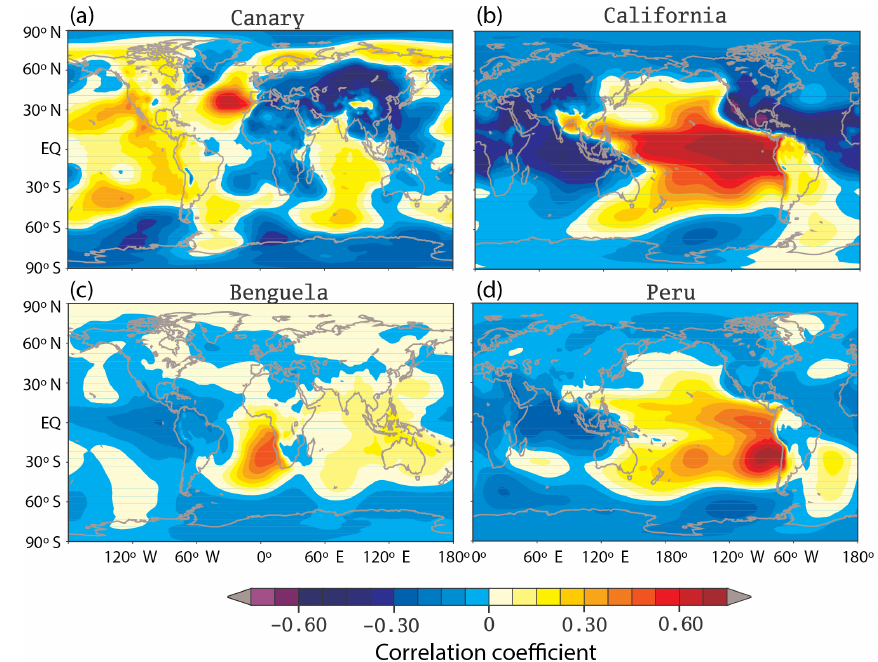
Figure 4. Correlation patterns between the seasonal (June–August, except for Benguela in September–November) upwelling index in each eastern boundary upwelling system and the simultaneous seasonal mean sea level pressure field simulated in one of the past1000 simulations ( r 1) (900–1849) with the Earth system model